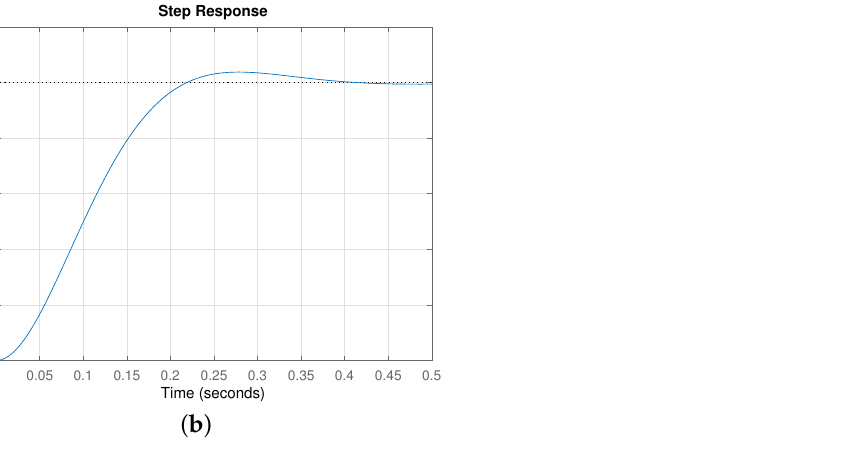
Figure 15. Motor position control system. Motor position control system. ( a ) Control system diagram.